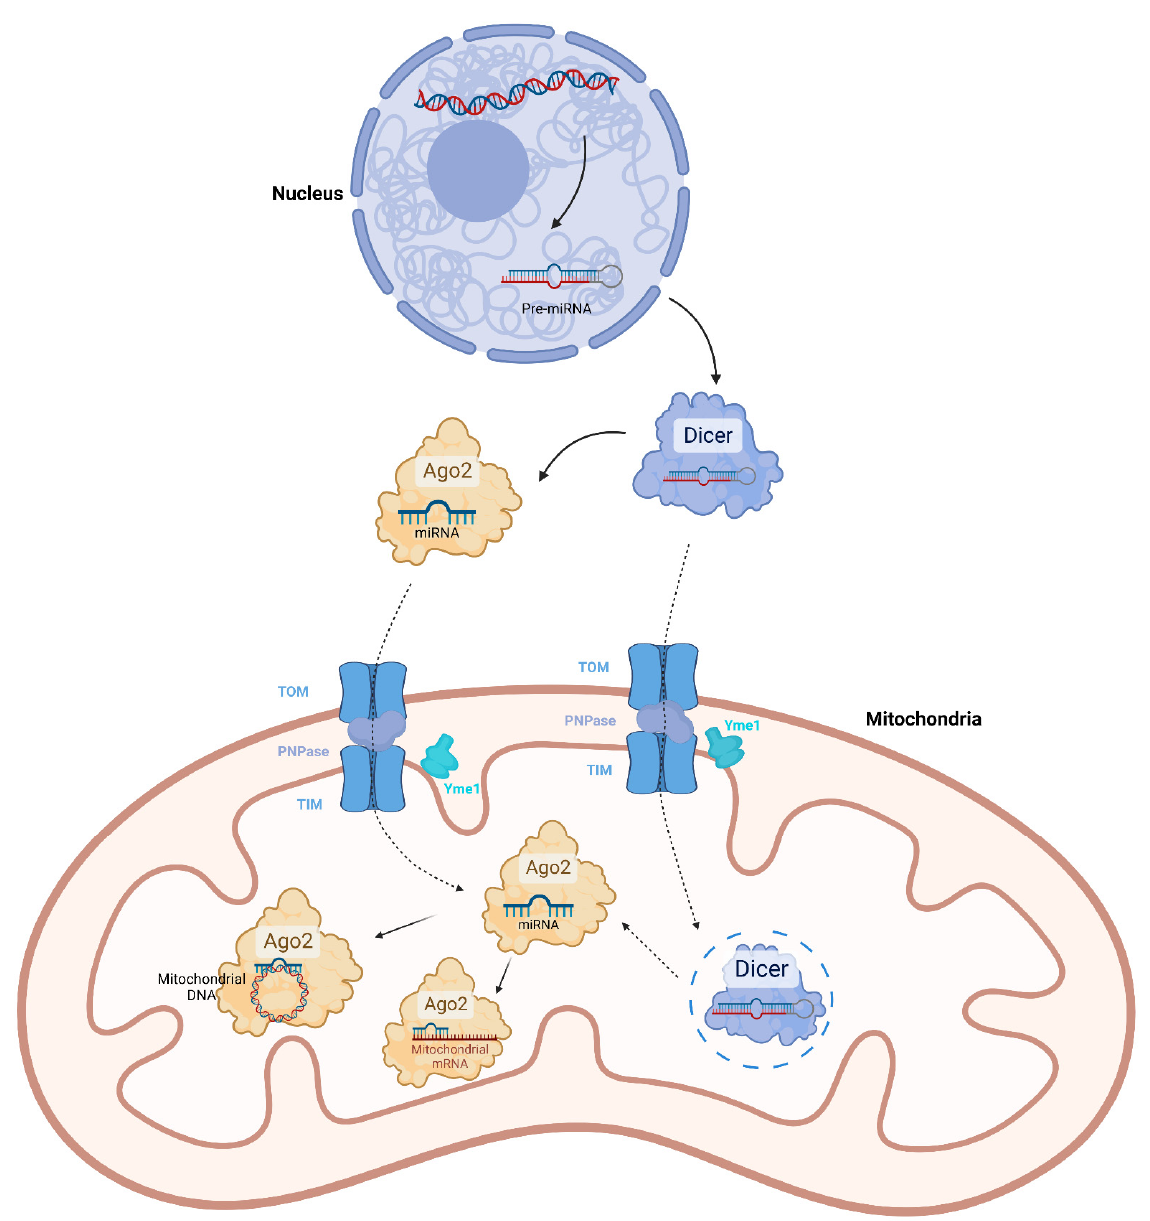
Figure 1. The biogenesis, translocation and function of mitochondrial miRNAs. Mitochondrial miRNAs are transcribed from nuclear genome. The mature miRNAs associated with Ago2 are translocated into mitochondria by PNPase. Pre-miRNAs are also present in mitochondria, which might be further cleaved into mature form by Dicer. However, the mitochondrial localization of Dicer is controversial (The related molecules and processes are labeled in dotted-line). The mitochondrial miRNAs either interact with mRNAs to regulate translation, or interact with DNA to regulate transcription. These mechanisms are